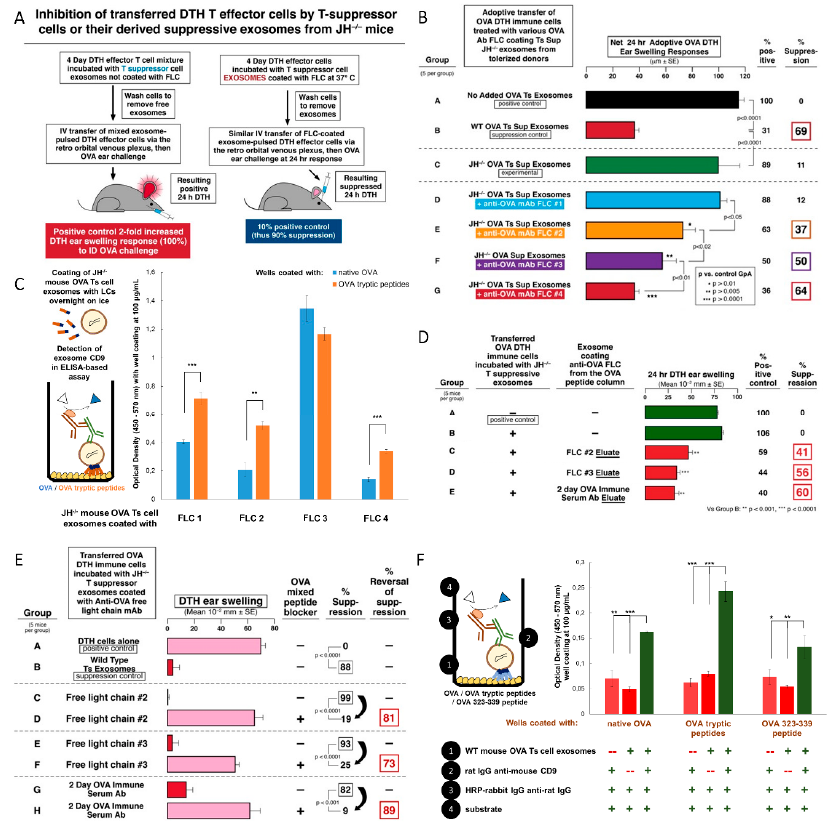
Figure 7. Inhibition of transferred OVA DTH e ff ector cells that were pulsed with exosomes from Ag-tolerized JH neg / neg mice that were in vitro coated with the four di ff erent anti-OVA Ab FLC. ( A ) Protocol: Inhibition of adoptively transferred OVA DTH e ff ector cells when preliminarily pulsed with exosomes from Ag-tolerized WT donors, compared to those from similarly Ag tolerized JH neg / neg mice, that in some cases were additionally coated in vitro with the four di ff erent anti-OVA mAb FLC. ( B ) Adoptive transfer of OVA DTH e ff ector cells pulsed in vitro with OVA-specific Ts cell-derived exosomes from Ag-tolerized JH neg / neg mice, reconstituted for suppression by in vitro coating with the four di ff erent anti-OVA mAb FLC. ( C ) ELISA-based assay (scheme—left) to evaluate the binding of JH neg / neg mouse Ts cell-derived exosomes coated with four di ff erent monoclonal anti-OVA Ab FLC to either native OVA or OVA tryptic peptides, showing the stronger binding to OVA tryptic peptides in the case of FLC 1, 2, and 4. ( D ) Successful reconstitution of suppression by coating of non-suppressive T cell exosomes derived from OVA Ag-tolerized JH neg / neg mice with anti-OVA mAb FLC numbers 2 and 3 or 2-day immune serum FLC eluted from OVA tryptic peptide-linked a ffi nity column. ( E ) Use of OVA tryptic peptides to potentially block anti-OVA mAb FLC that coat Ts cell-derived suppressive exosomes. The OVA peptides block anti-OVA mAb FLC and FLC from OVA-immune serum that coated Ts cell-derived suppressive exosomes from Ag-tolerized JH neg / neg mice, on adoptive transfer of DTH, mediated by a mixture of APCs and OVA-specific DTH e ff ector T cells. ( F ) ELISA-based assay (scheme—left) to evaluate the binding of wild type mouse Ts cell-derived suppressive exosomes to either native OVA, OVA tryptic peptides or OVA 323-339 antigenic determinant, showing that exosomes originally coated with anti-OVA FLC can bind to all assayed OVA preparations. Results of in vivo assays are shown as delta ± standard error (SE, n = 5 mice in each group), and of in vitro assays as mean ± standard deviation (SD, n = 3 wells in each experimental repetition), one-way ANOVA with post hoc RIR Tukey test or two-tailed Student’s t -test, * p < 0.05; ** p < 0.01; *** p <